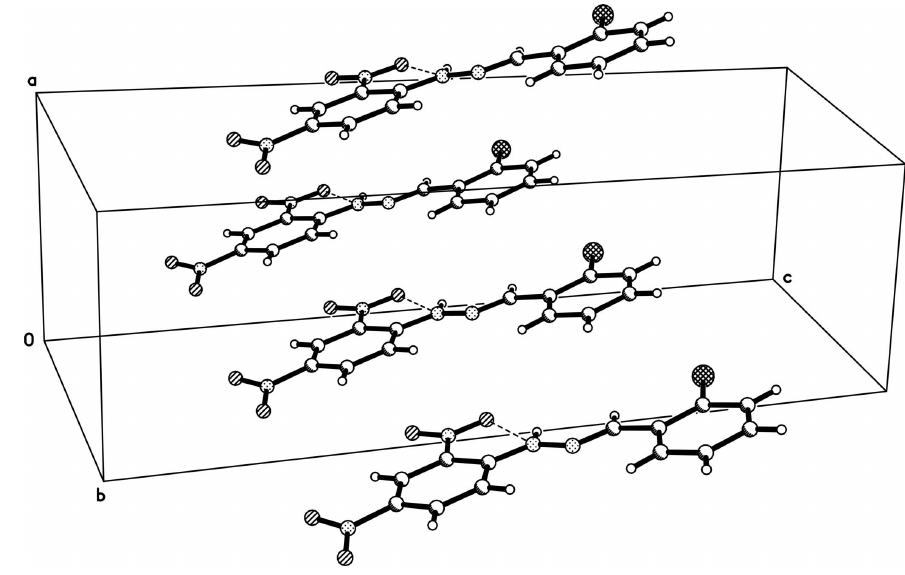
Figure 2 The molecules are stabilized by intramolecular N—H···O hydrogen bonds. The dashed lines indicate hydrogen bonds.